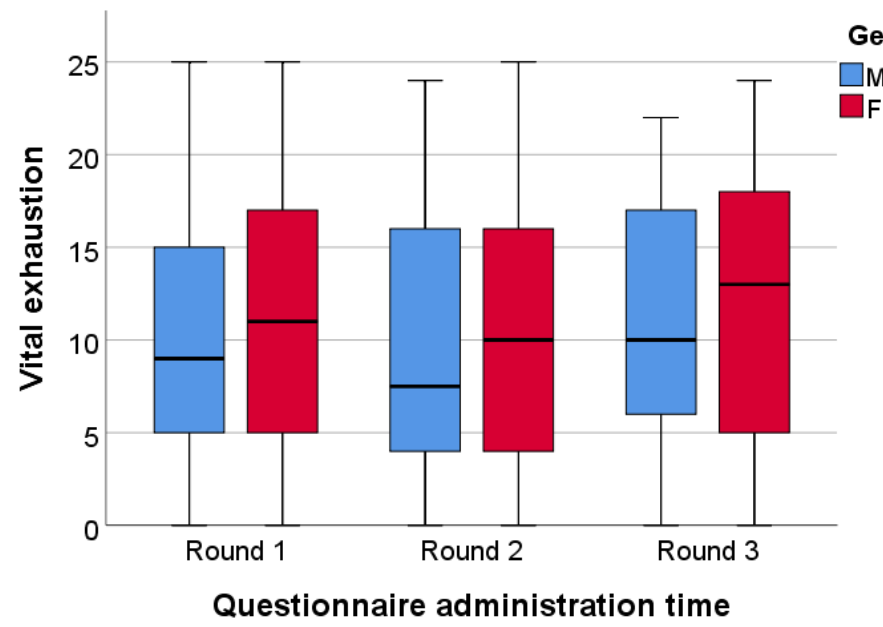
Figure 4. Gender differences in vital exhaustion among Hungarian students.